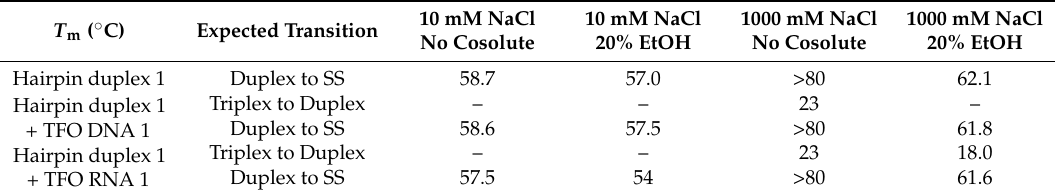
Table 4. Melting temperatures ( T m , ˝ C) calculated from thermal denaturation curves of hairpin duplex and the expected triplexes formed with hairpin and DNA- or RNA-TFOs in the presence of EtOH and 10 nM–1 M NaCl solutions a